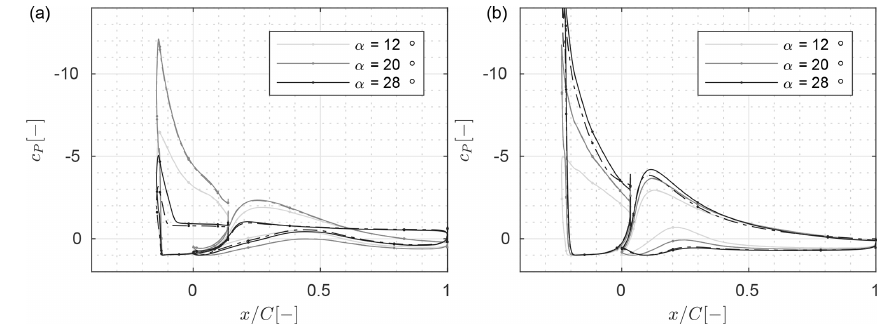
Figure 18. Pressure distribution from CFD for the clean ( − ) and the rough ( − . ) profiles at different angles of attack for (a) configuration C and (b) configuration C ∗ .